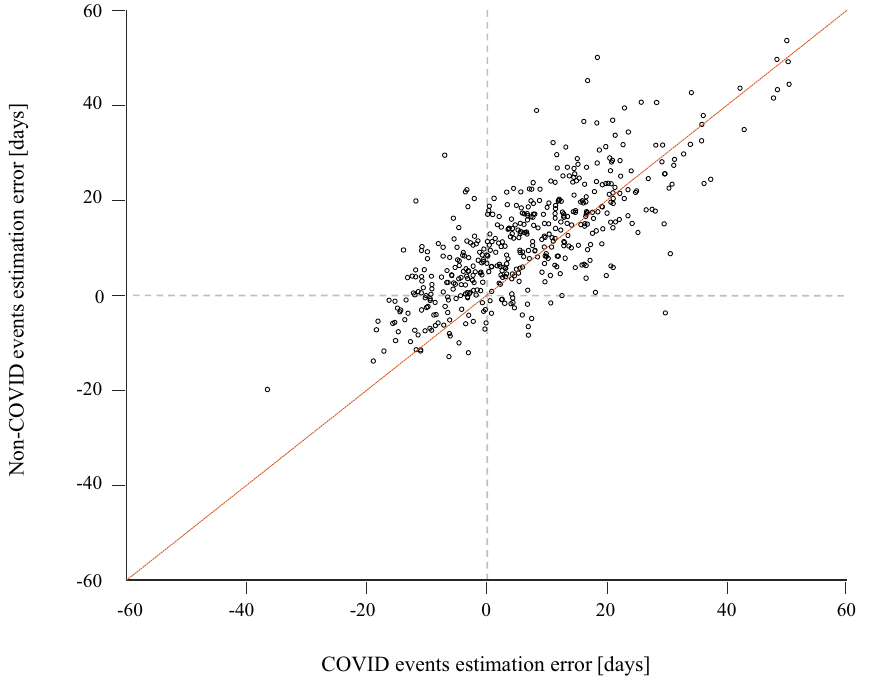
Figure 2. OVID and Non-COVID estimation errors. The scatter plot depicts the estimation errors of all participants (n = 469). The x-axis represents average estimation error of COVID events, and the y-axis represent the average estimation error of non-COVID events. The red line represents the equality line: indicating no difference in estimation error between COVID and Non-COVID events. The figure indicates that for both types of events, participants tended to over- rather than under-estimate time. Most participants are above the equality line, indicating that there was more over-estimation for non-COVID than for COVID